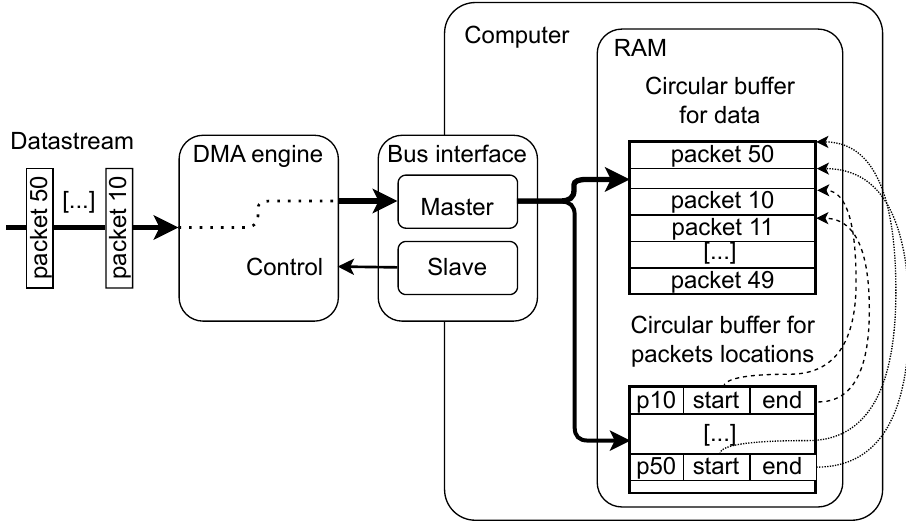
Figure 5. Data flow in the DMA engine. The data packets are stored in the primary big circular buffer. The locations of the received packets are stored in a smaller circular buffer, enabling quick access to the desired